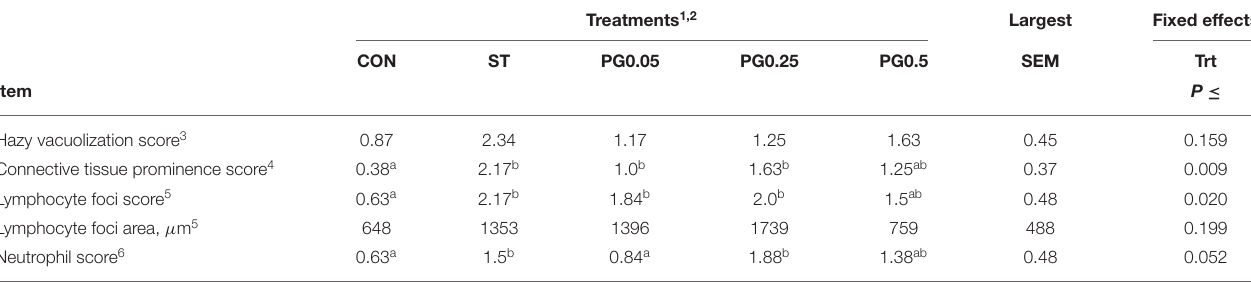
TABLE 6 | Liver histopathological effects of a ceramic particle fed to pigs after a S. enterica serotype typhimurium infection. Treatments 1,2 Largest Fixed